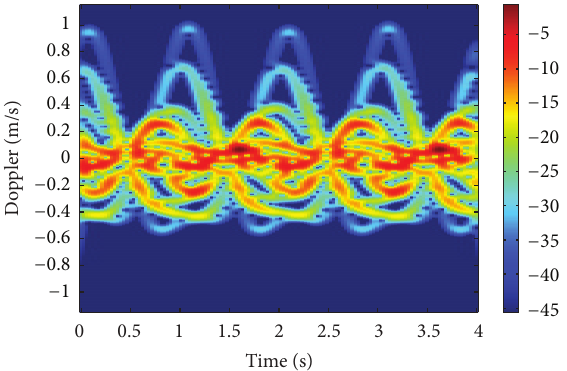
Figure 1: Simulated micro-Doppler for a man walking on a treadmill in the radial direction toward the radar at